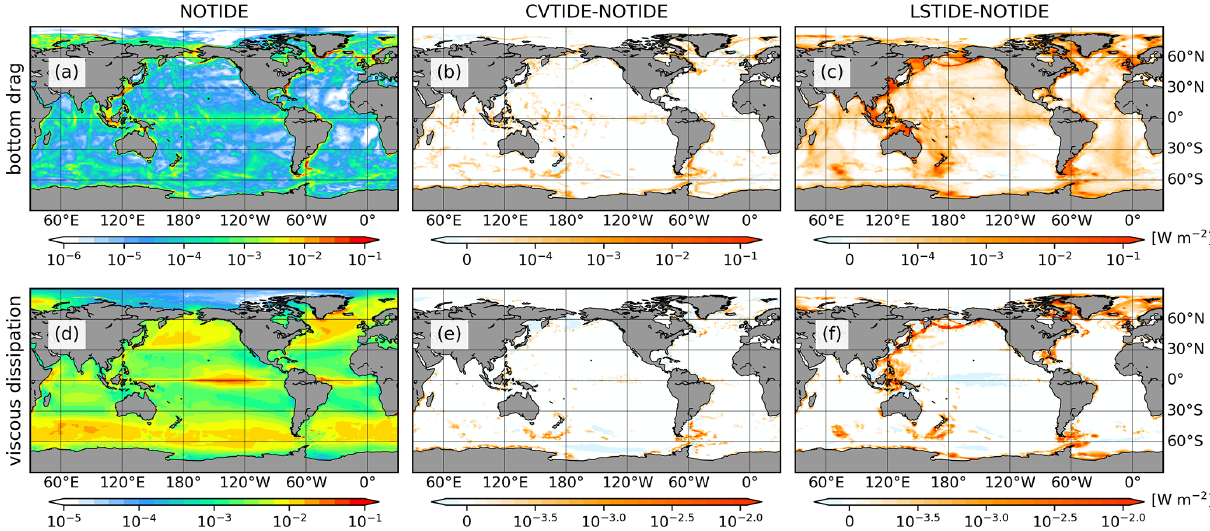
Figure 9. Horizontal distribution of vertically integrated energy dissipation terms in Table 1 (we change the sign so that positive values represent energy dissipation). Panels (a) – (c) and (d) – (f) indicate bottom drag and viscous dissipation (including horizontal and vertical components), respectively. Panels (a) and (d) show the control run, and the other panels show the differences. Colour bars are shown in decimal logarithmic scales.